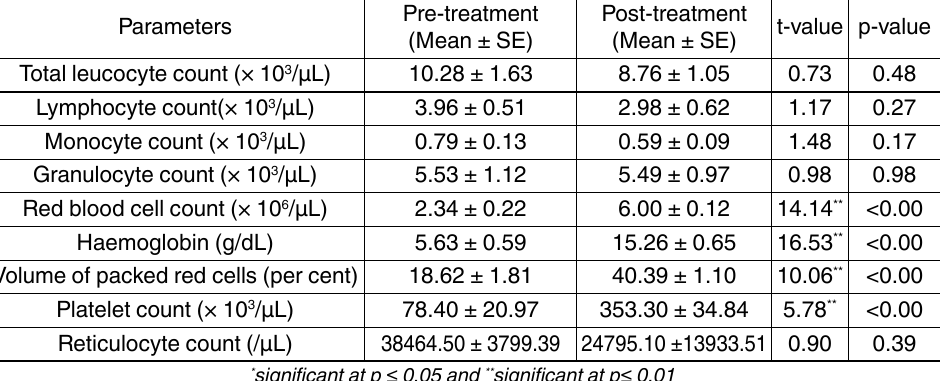
gibsoni infection in dogs. Twenty dogs with a reticulocyte count of less than 60,000/ μL, haematocrit less than 30 per cent, and associated with B. gibsoni infection were studied in detail. These dogs were randomly divided into Group I and II of ten animals each. Haematology revealed severe anaemia and thrombocytopenia in both the groups. The mean total protein and albumin values were similar in both the treatment groups and the healthy dogs. Normal levels of total protein and albumin ruled out the possibility of long- term protein deficiency as the reason for non- regenerative anaemia. A high serum iron, a normal TIBC and an elevated PTS indicated a normal to high level of iron in the body which in turn ruled out the possibility of iron deficiency to be the reason for anaemia. Dogs of both groups i.e ., with and without